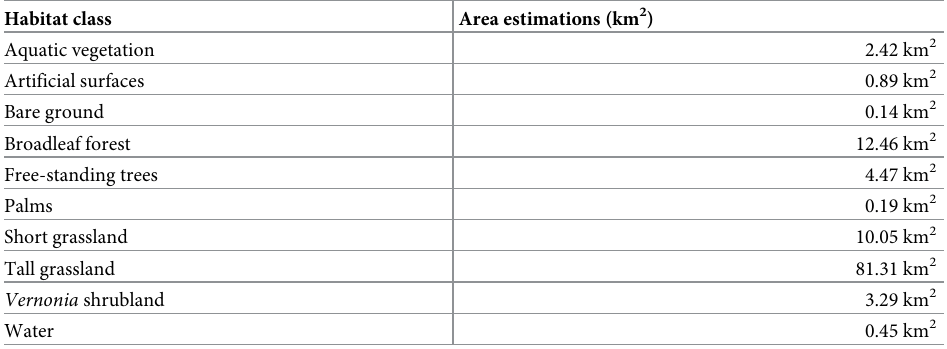
Table 1. Area estimations per habitat